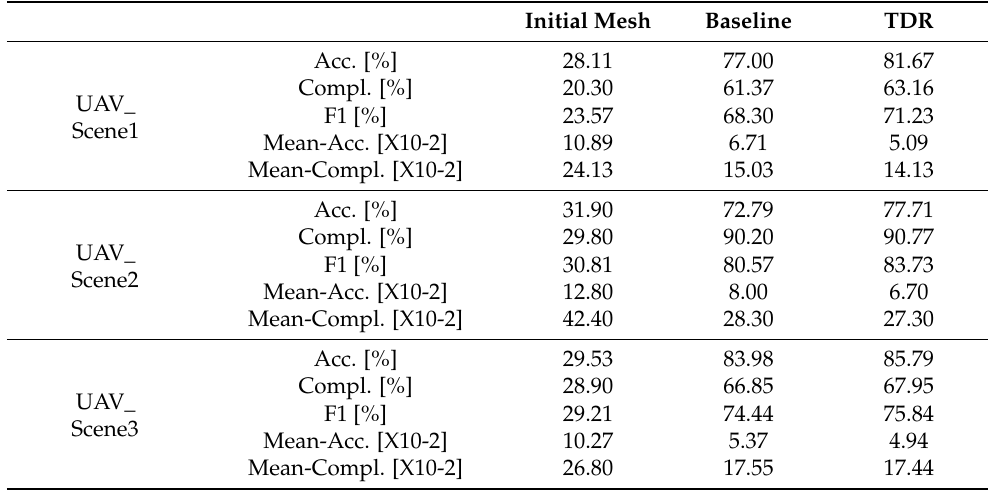
Table 2. Quantitative evaluation of the BlenderMVS dataset. Acc. means accuracy and Compl. represents